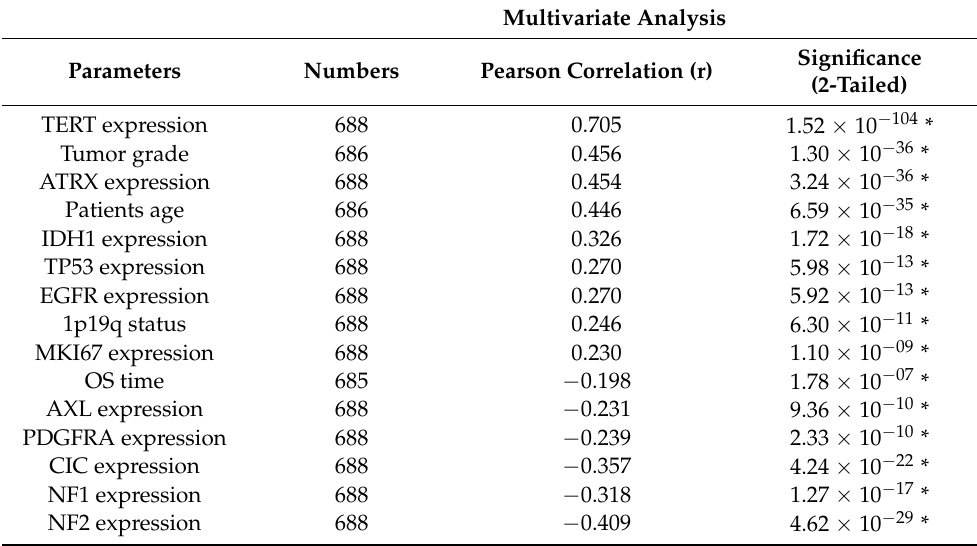
Table 1. Correlation of risk factors associated with GRPEL2 expression in